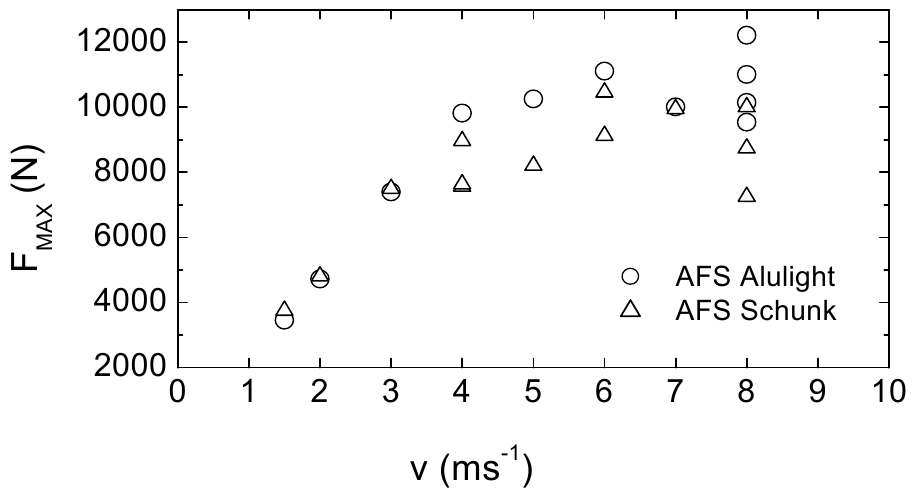
Figure 10. Contact force peak—velocity curves for AFS panels.